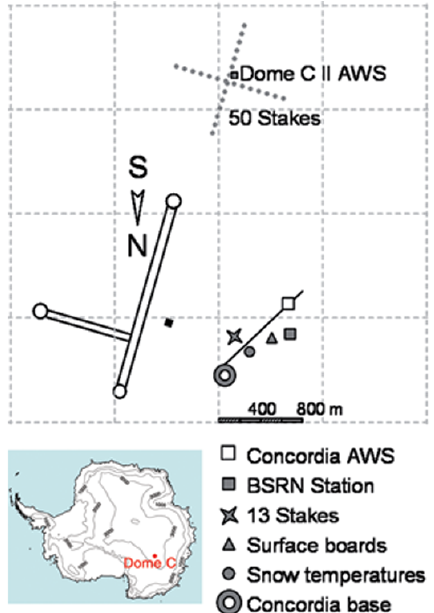
Fig. 1. Top: plan of the immediate surroundings of Concordia research station indicating all measurement sites. The measure- ment site “Surface boards” includes the surface boards SB acc and SB clear and the tables used for measurements of solid deposits. Bot- tom: map of Antarctica indicating Dome